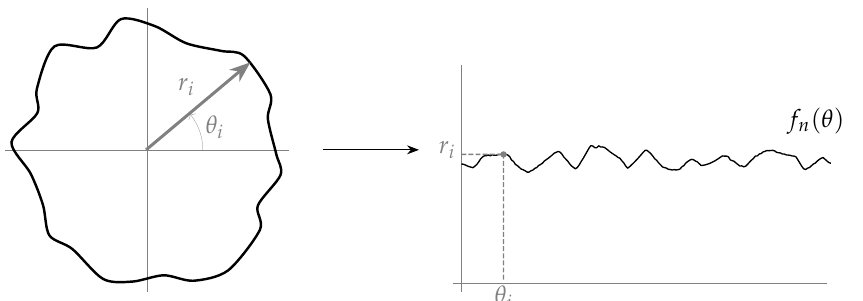
Figure 9. Radius distribution of the shape shown in Figure 8a.